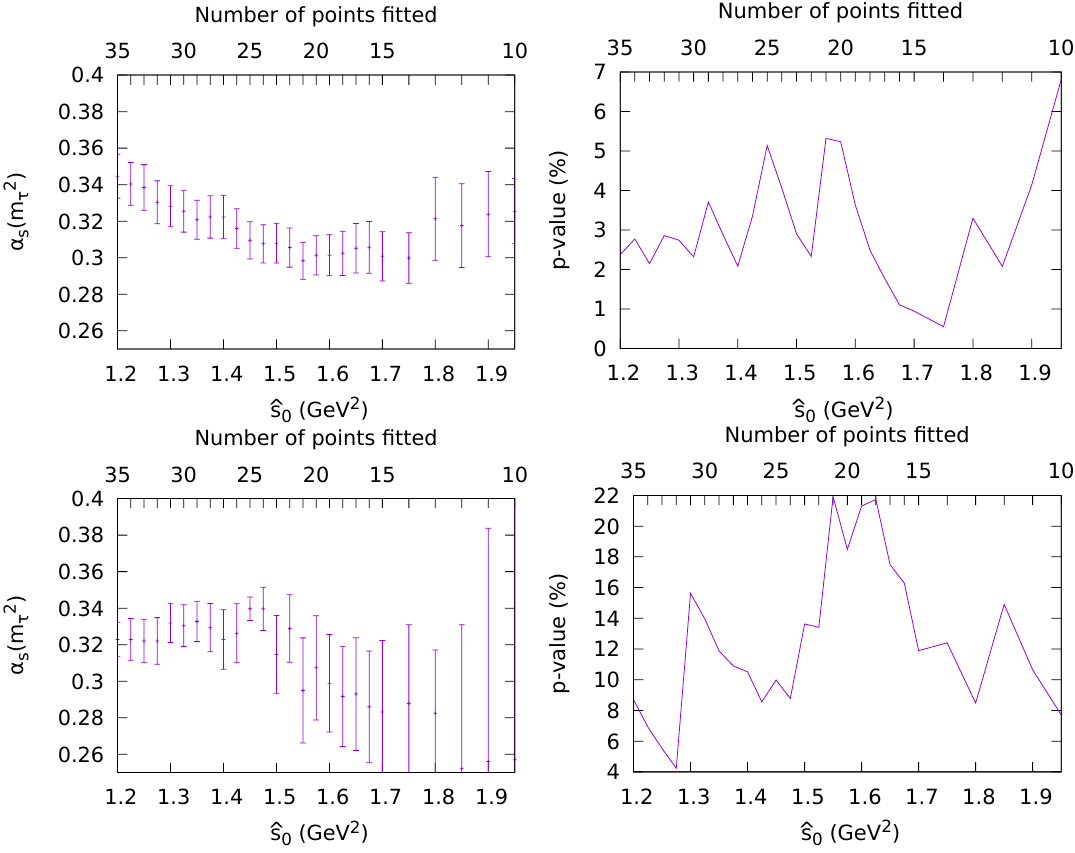
Figure 4 . Fitted values of α s in FOPT (left) for different choices of ˆ s 0 , with the default ansatz, and associated p-values (right). The top (bottom) figures correspond to the vector (axial) channels